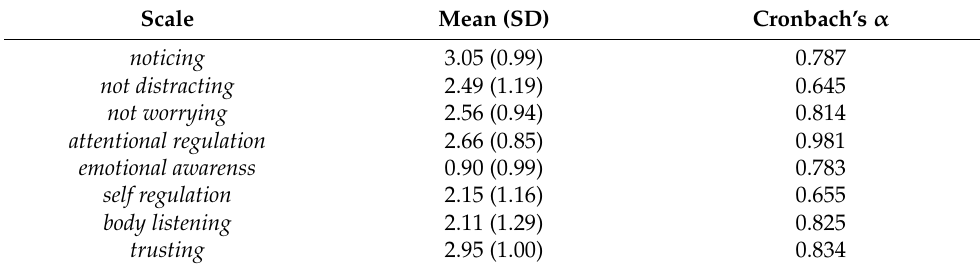
Table 1. MAIA scale mean values